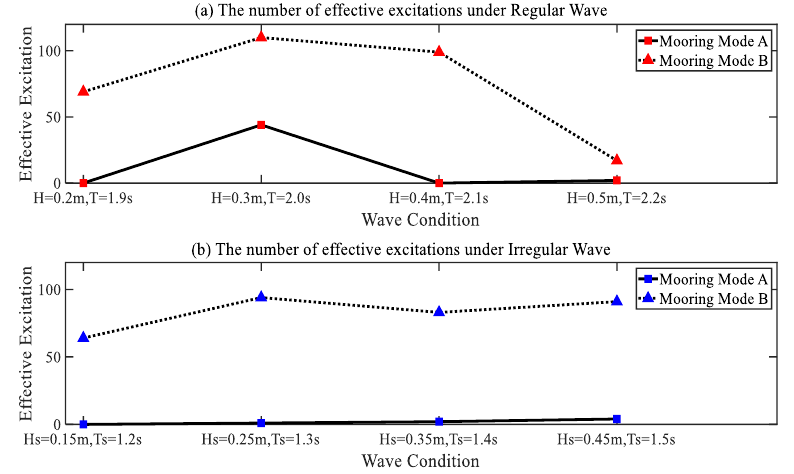
Figure 14. The total number of effective excitations for the buoy under different wave conditions in the single-anchor line mooring mode.